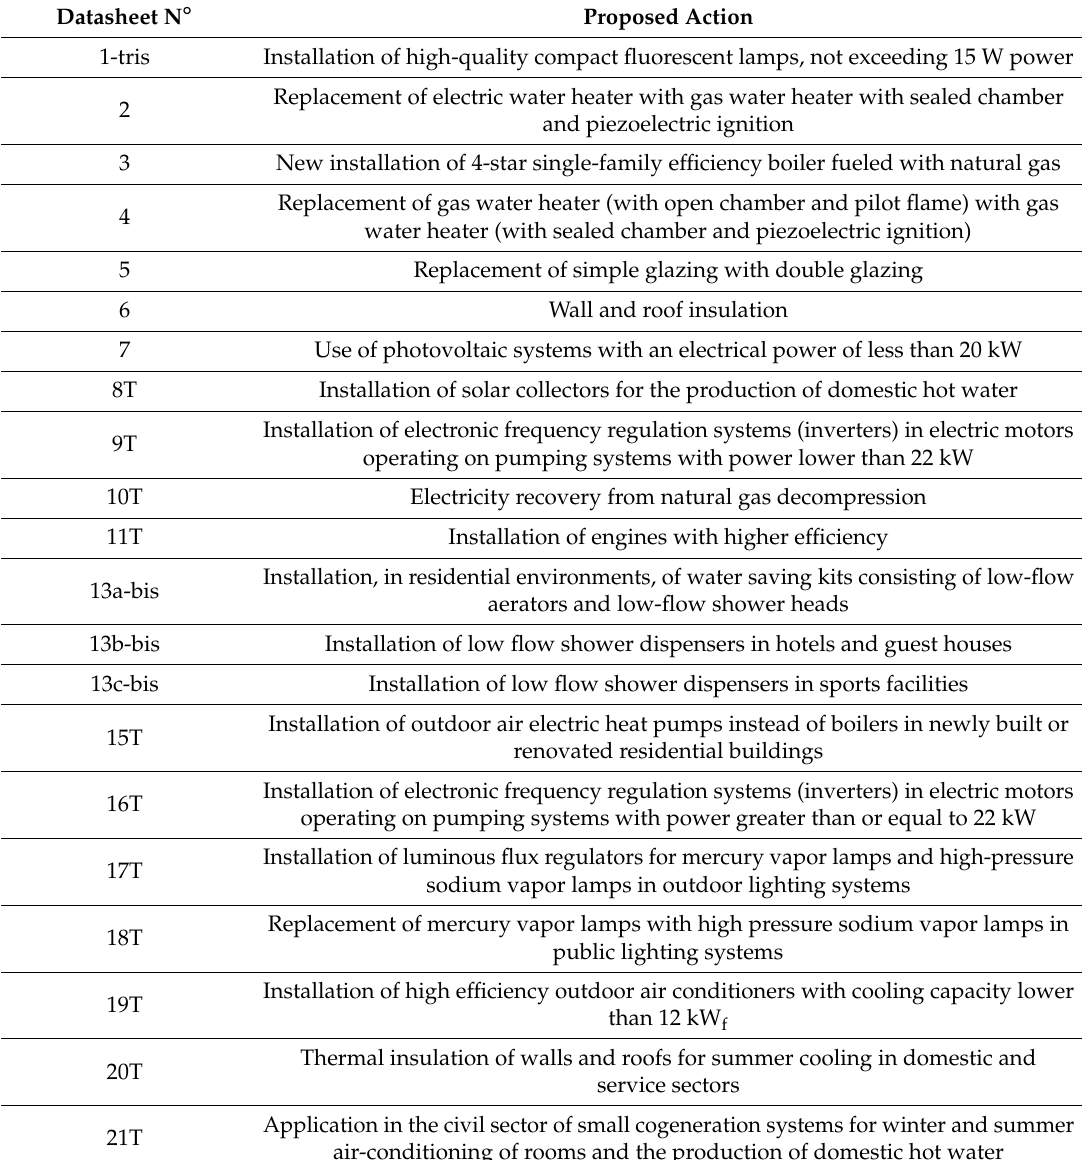
Table A1. ARERA technical